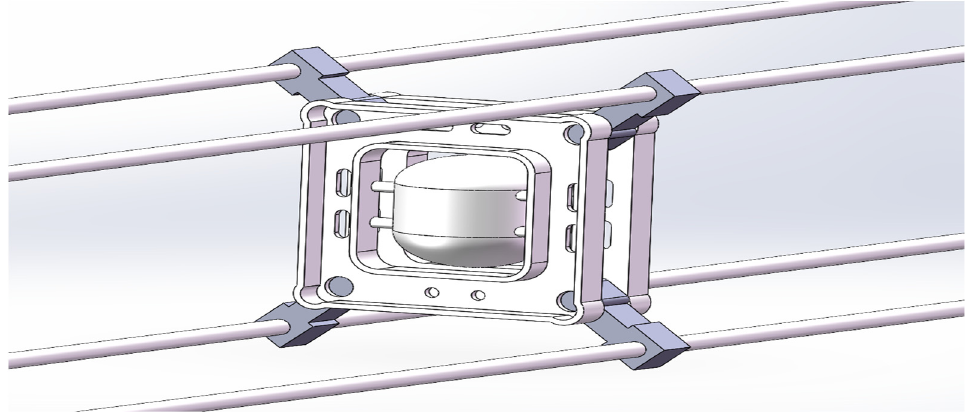
Figure 4. 3D structure diagram of improved